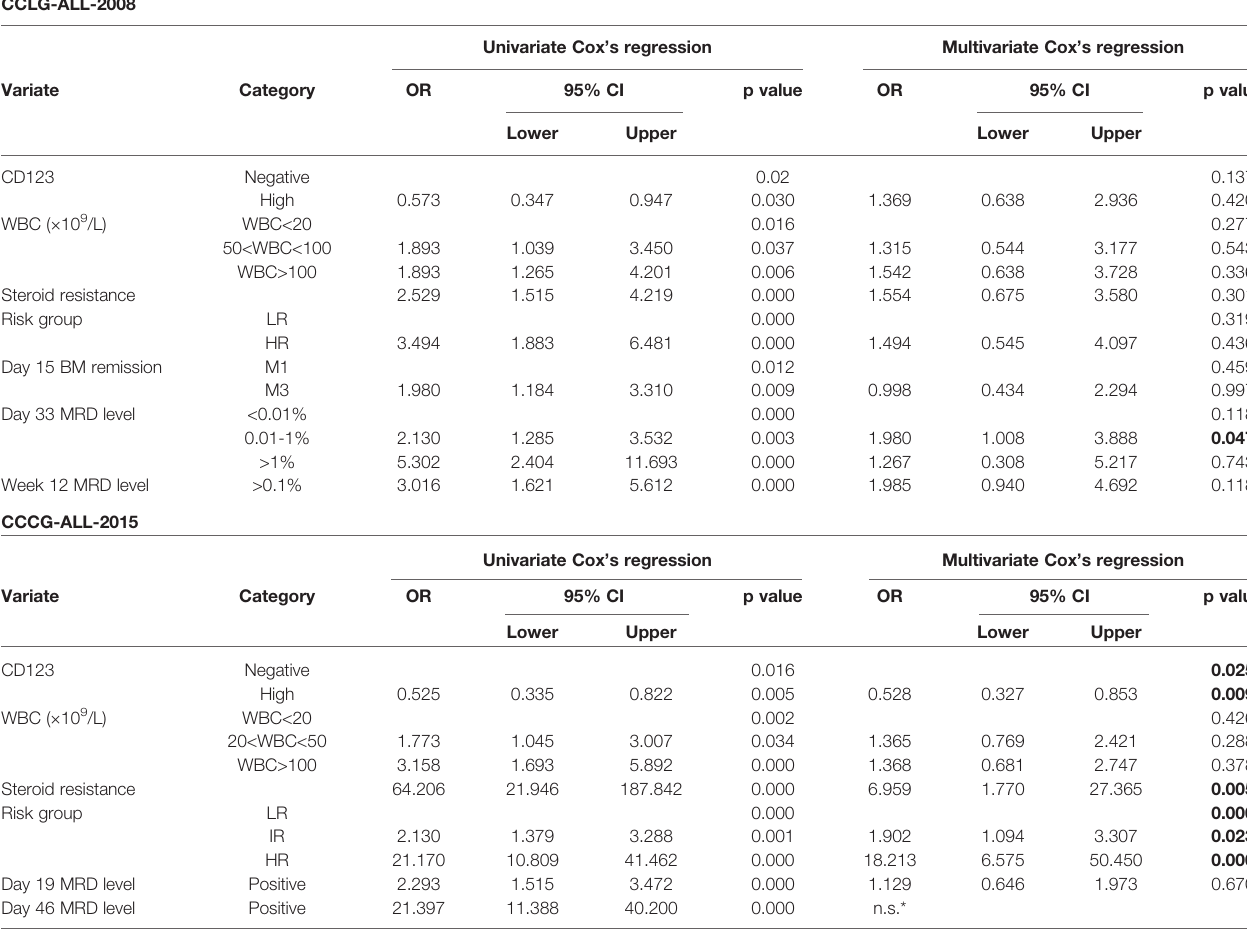
TABLE 3 | Cox ’ s proportional hazards regression model analysis of factors affecting event-free survival (EFS).